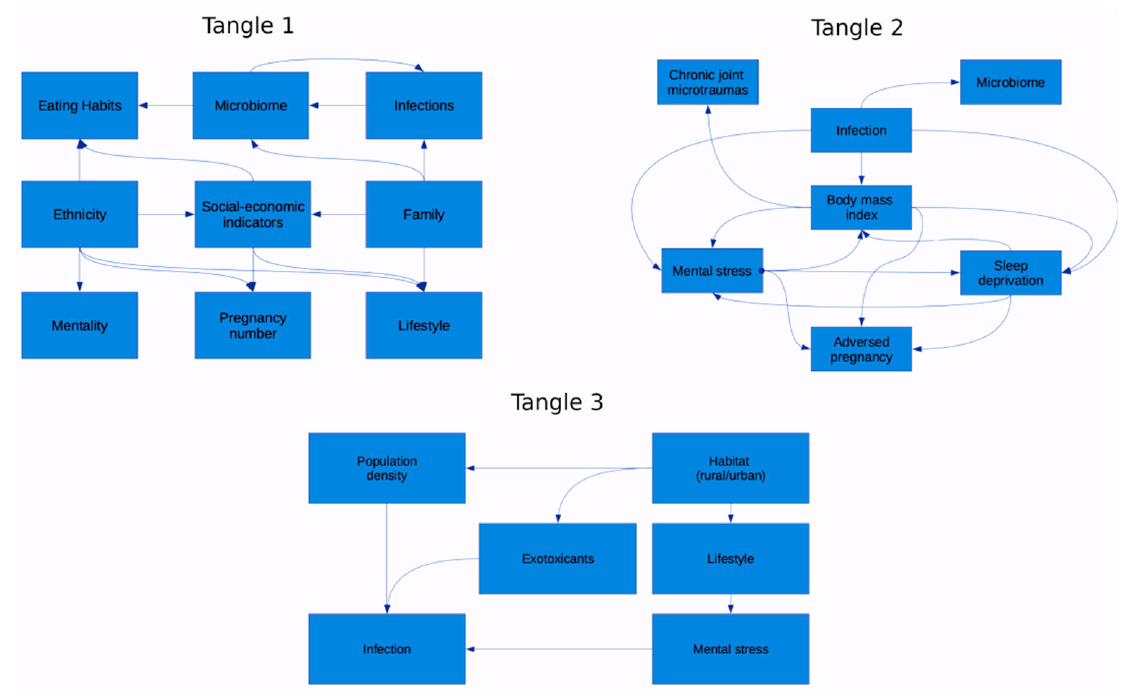
Figure 5. Network of challenging non-genetic factors.